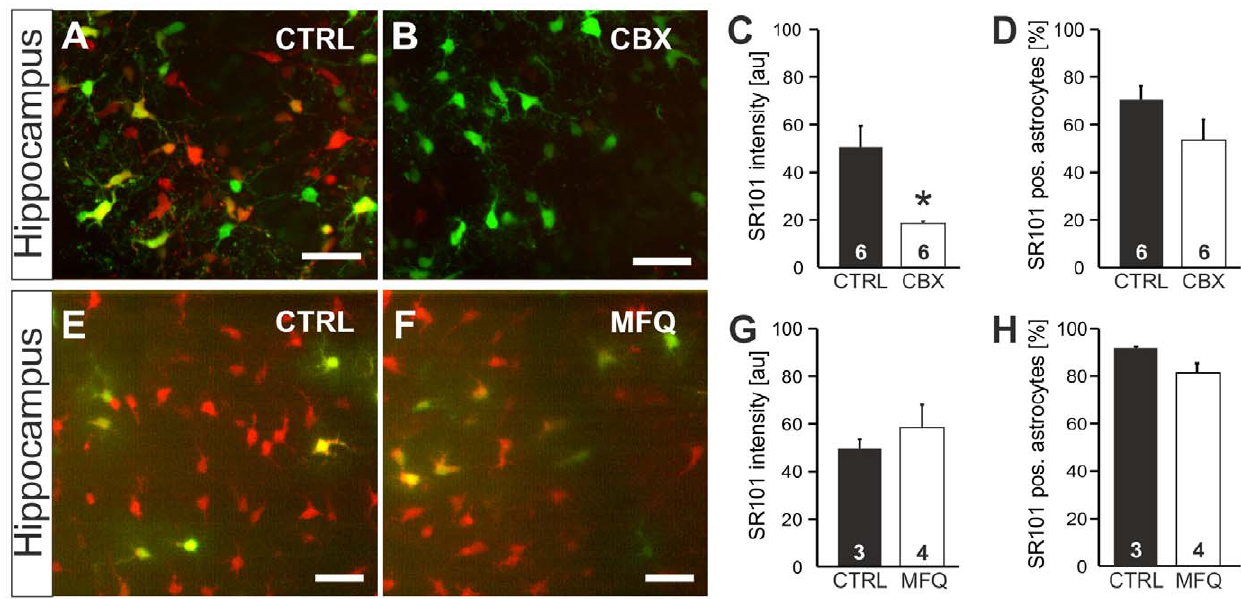
Figure 6. Effects of the hemichannel blocker carbenoxolone and mefloquine on SR101-labeling in the hippocampus. A–D: Carbenoxolone (CBX) reduced SR101-labeling in the hippocampus. A: Overlay of EGFP (green)- and SR101-fluorescence (red) in CTRL conditions. B: With CBX (100 m M) present during SR101-staining, SR101-fluorescence is significantly reduced. C,D: Statistical comparison of SR101-labeling of EGFP- labeled astrocytes in the absence (CTRL) and presence of CBX reveals significant reduction of fluorescence intensity but no significant difference in the fraction of SR101-positive astrocytes. E: Overlay of EGFP- and SR101-fluorescence after a staining in CTRL conditions. F: Overlay of EGFP- and SR101-fluorescence after a staining with Mefloquine (MFQ, 50 m M). G,H: Statistical comparison: Neither the staining intensity (G) nor the number EGFP-positive astrocytes that were labeled with SR101 (H) was changed. Scale bars: 40 m m.